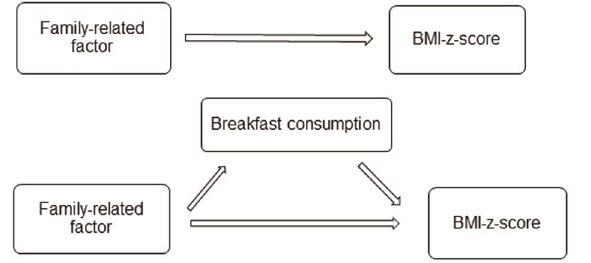
Figure 1. Mediation model with family-related factor (inde- pendent variable), breakfast consumption (mediator), BMI-z- score (dependent variable) and the different coefficients. c- coefficient: estimate of the association between family-related factor item and BMI-z-score. c’-coefficient: estimate of the association between family-related factor and BMI-z-score, adjusted for children’s breakfast consumption (mediator). a –coefficient: estimate of the association between family-related factor and children’s breakfast consumption (mediator). b_coefficient: estimate of the association between children’s breakfast consumption (mediator) and